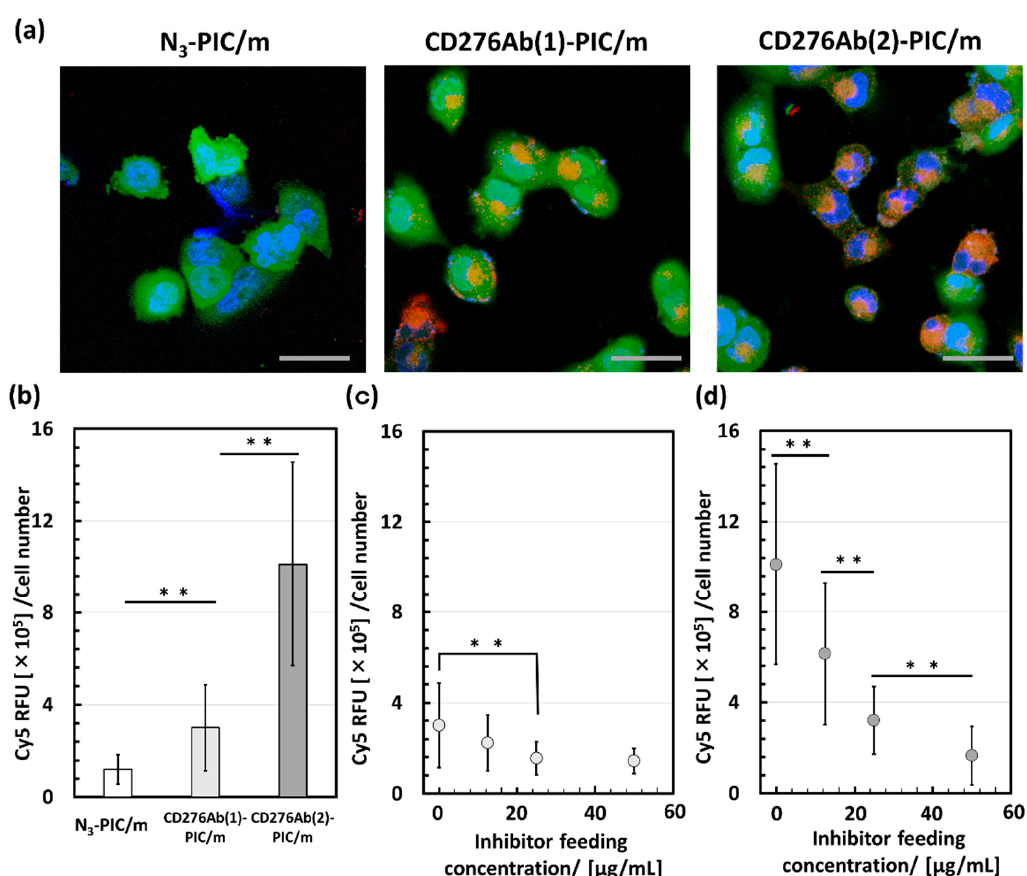
Figure 5. In vitro evaluation of internalization efficiency of CD276Ab installed micelles. ( a ) N 3 - PIC/m, CD276Ab(1)-PIC/m, and CD276Ab(2)-PIC/m were incubated with DAOY cells at 10 µ g/mL (polymer concentration) for 3 h, then counterstained with Hoechst 33258. The fluorescence of Cy5 (red), GFP (green), and the nucleus (blue) were detected using a CLSM. The scale bar indicates 50 µ m. ( b ) Cy5 fluorescence intensity within each cell was quantified by ImageJ ( n = 50) and then tested for significant difference via a Student’s t -test followed by Bonferroni correction for multiple analyses. A significant difference was detected and represented as ** p < 0.001. Error bars indicate standard deviation. An inhibition assay was conducted for ( c ) CD276Ab(1)-PIC/m and ( d ) CD276Ab(2)- PIC/m. The Cy5 fluorescence intensity within each cell was quantified by ImageJ ( n = 50) and then tested for significant differences via a Student’s t -test followed by Bonferroni correction for multiple comparisons. Significant difference was represented as ** p < 0.001. Error bars indicate standard